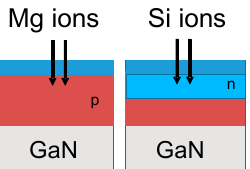
Figure 1. Mg ion implantation and double ion implantation of Mg and Si.